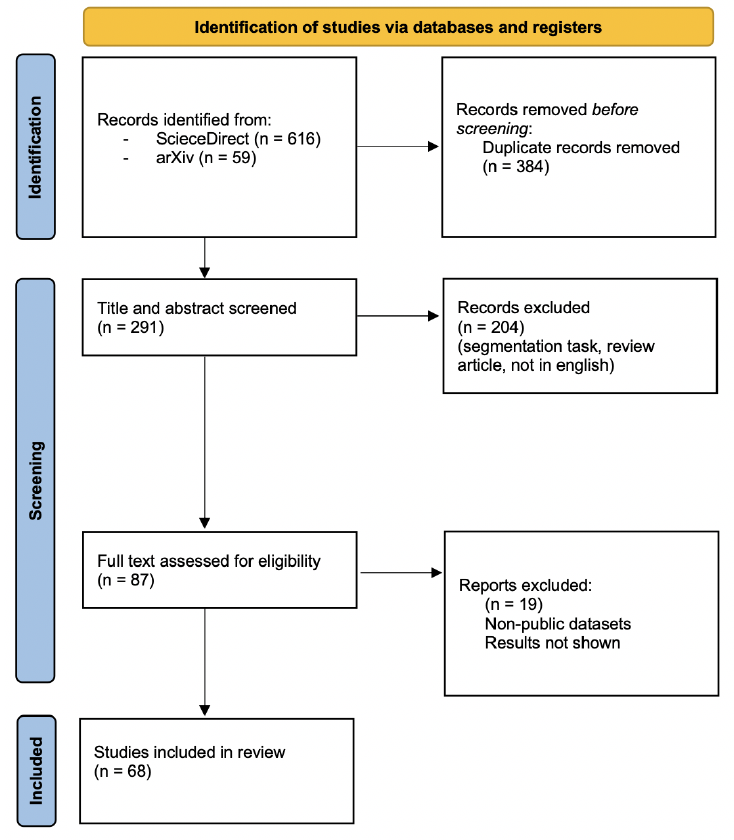
Figure 3. PRISMA flow